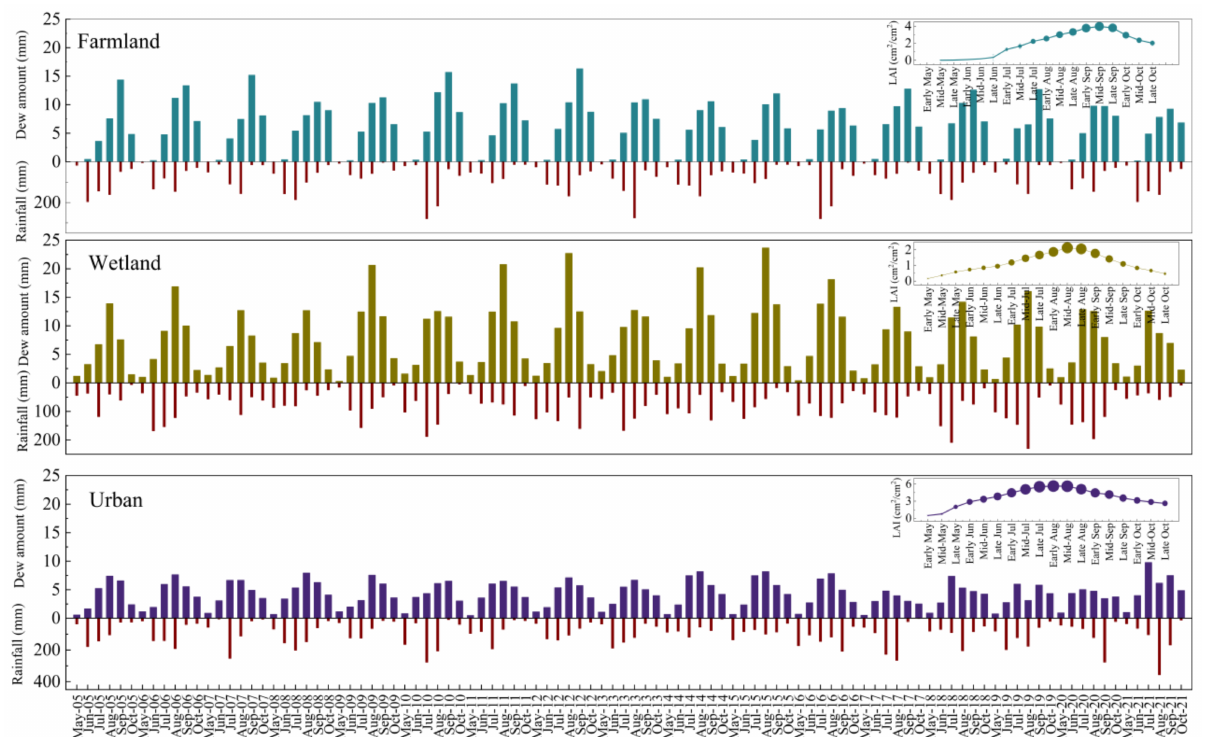
Figure 3. The monthly dew amount, rainfall and LAI in Lishu, Fujin and Changchun in the growing seasons from 2005 to